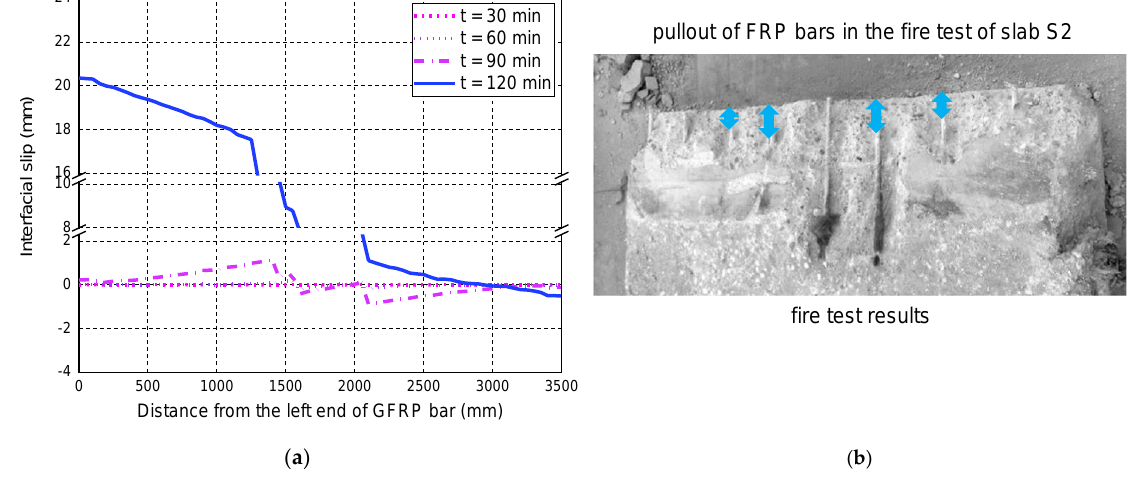
Figure 15. Interfacial slip distributions along the GFRP bar length of S2: ( a ) FE predictions; ( b ) the observed pullout failure mode of GFRP bars.